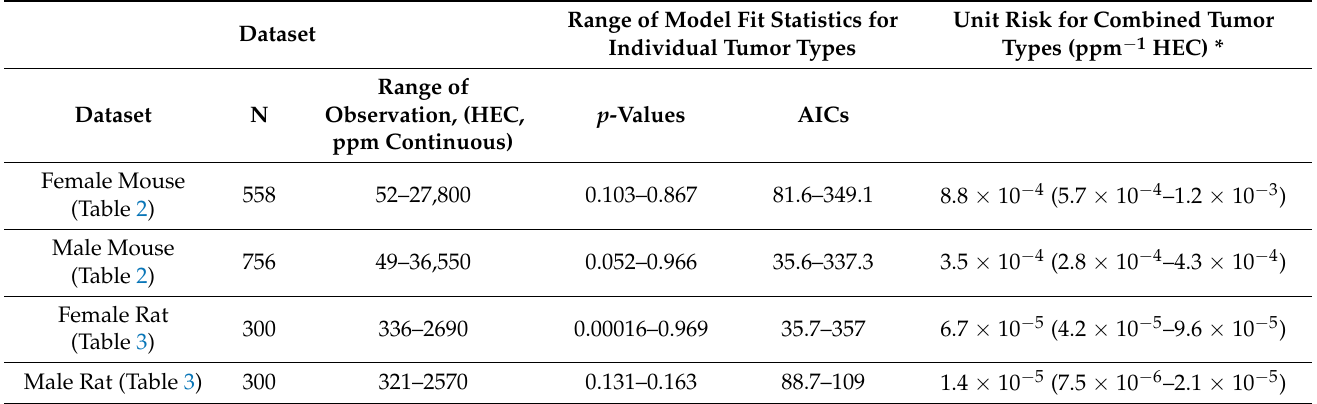
Table 7. Unit risk values based on tumors in mice and rats.